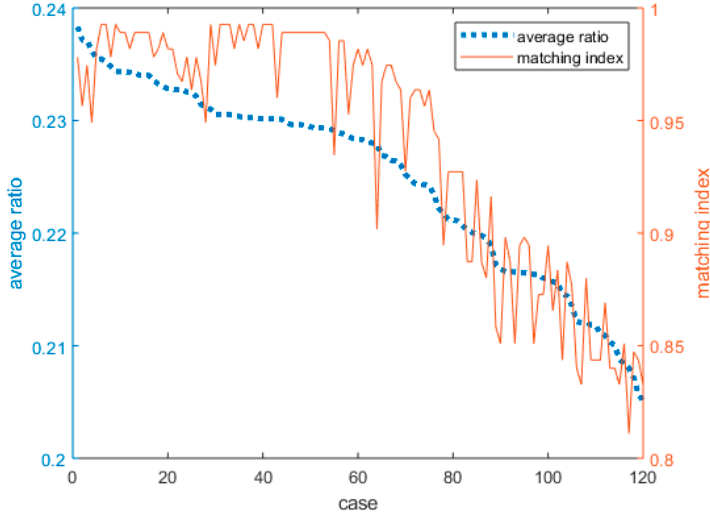
Figure 12. The average ratio of overlapping areas to the various pairs of the individual maps of the merged map in experiments and the corresponding matching indices. One-hundred and twenty different pairs of individual maps were randomly produced from the merged map and rearranged according to the average ratio of overlapping areas to individual maps. The matching index between the individual maps decreases macroscopically according to the average ratio.